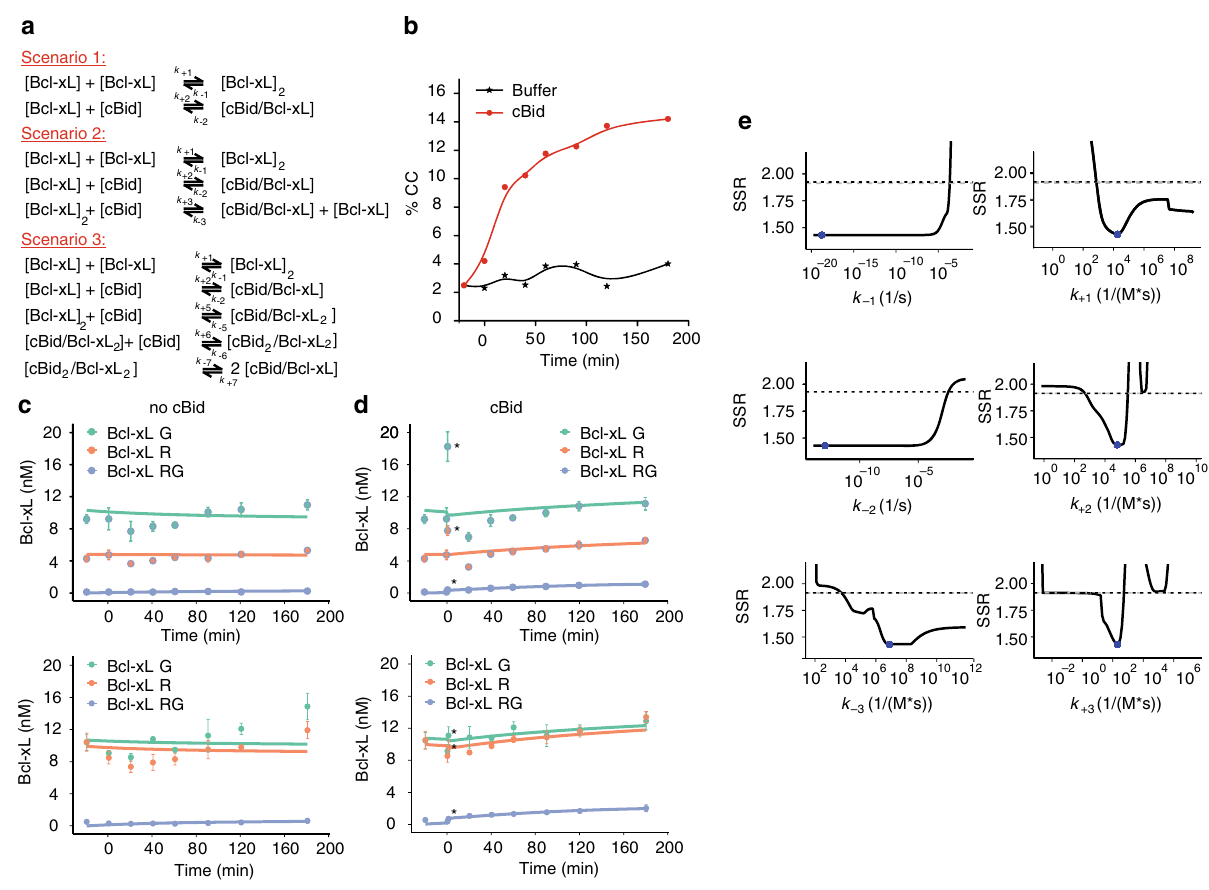
Fig. 3 Bcl-xL forms stable dimers in solution that exchange in presence of cBid. a Possible reaction scenarios between cBid and Bcl-xL in solution tested by modeling. b FCCS kinetic experiment on Bcl-xL R /Bcl-xL G dimerization in absence and presence of cBid (exemplary experiment out of n = 3). c , d Best fi t of ODE model considering scenario 2 to the evolution of fl uorescent Bcl-xL species based on the data shown in b . The upper and the lower panels show two independent experiments (mean and error bars as s.d. of three technical repetitions) with the Y -axis corresponding to the concentration of Bcl-xL particles. The fi rst data point in presence of cBid is introduced as t = 1 min and highlighted in the fi gure by asterisk . This is applicable as each data point had a total FCS measurement time of 2 min. e Likelihood pro fi les of model parameters that de fi ne rate constants. The fi tted parameter is shown as a blue dot , the reoptimized SSR is shown as black line and the dashed grey line indicates the con fi dence limit. FCCS fl uorescence cross correlation